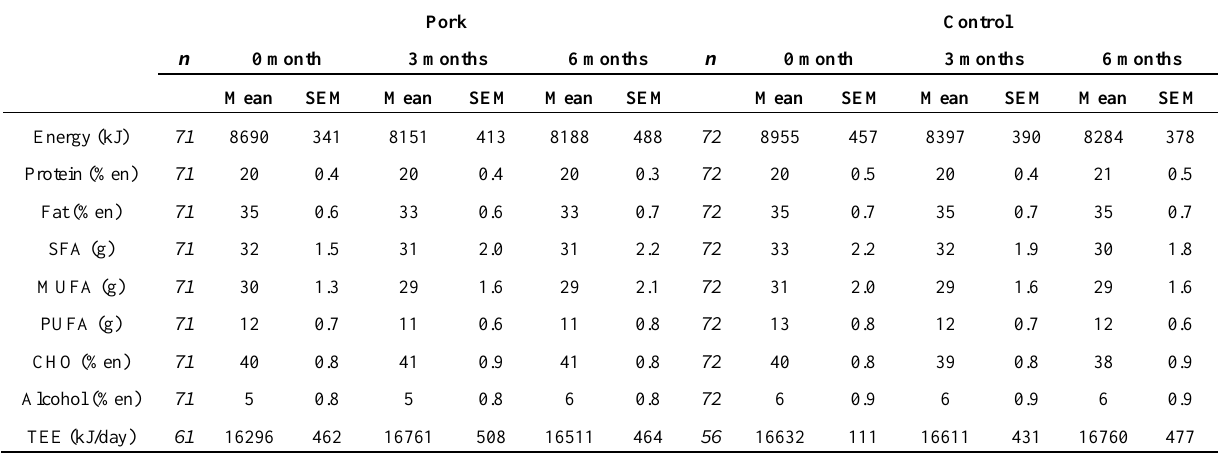
Table 2. Average values for energy, macronutrients and total energy expenditure of volunteers in the pork and control groups at baseline and 3 and 6